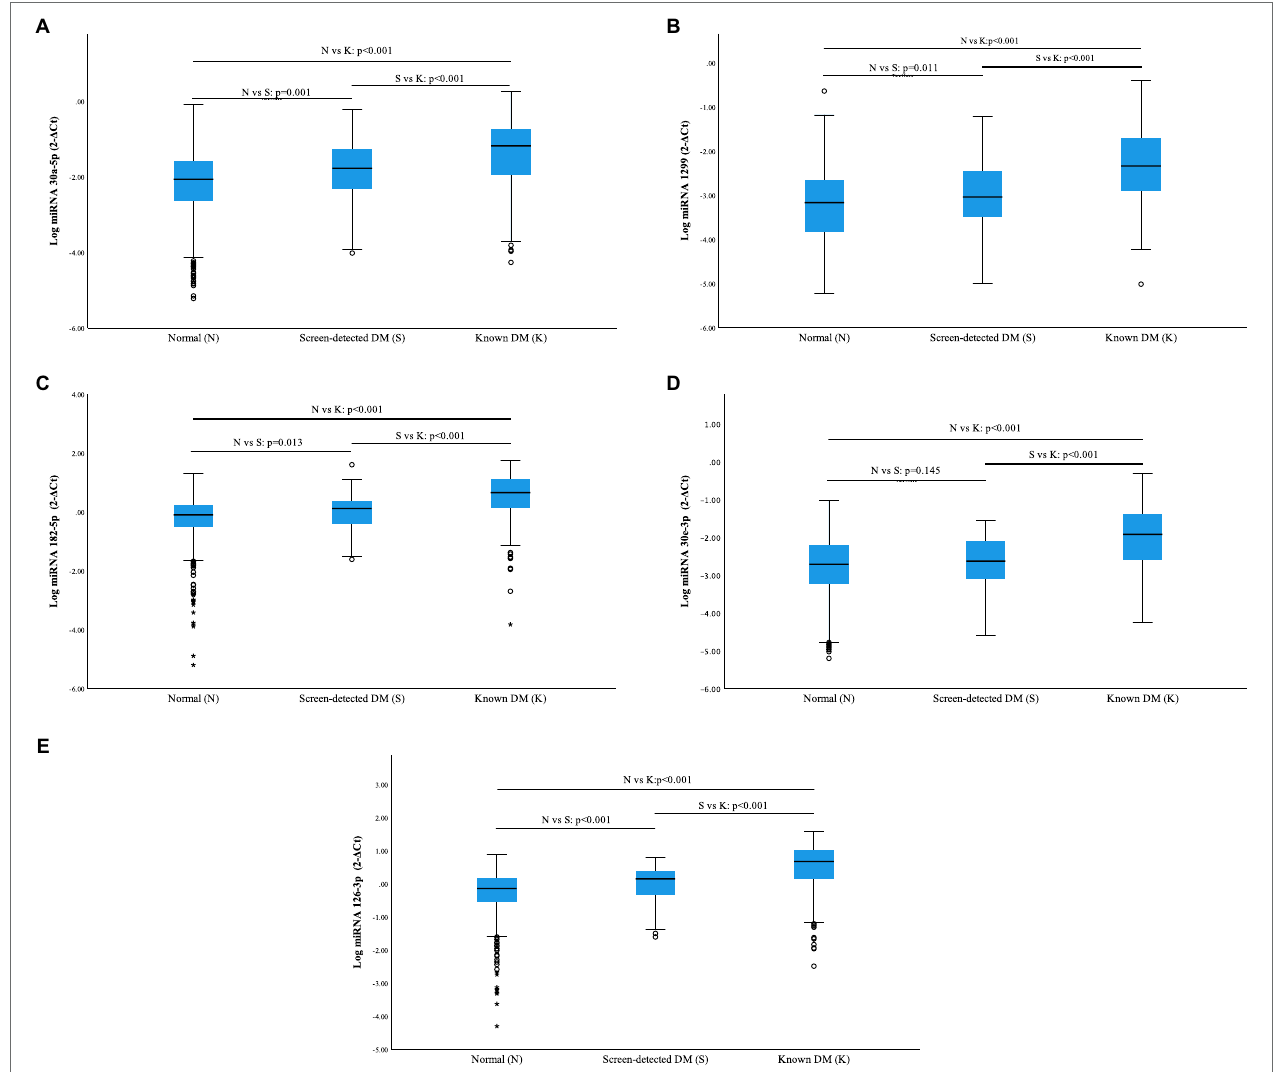
FIGURE 1 | Relative expression of miRNAs according to glycaemic status using log miRNA 2 −Δ Ct . Normalization was relative to the expression of miR-16-5p. Data are shown as median (25th–75th percentile). (A) miR-30a-5p; (B) miR-1299; (C) miR-182-5p; (D) miR-30e-3p; and (E) miR-126-3p.